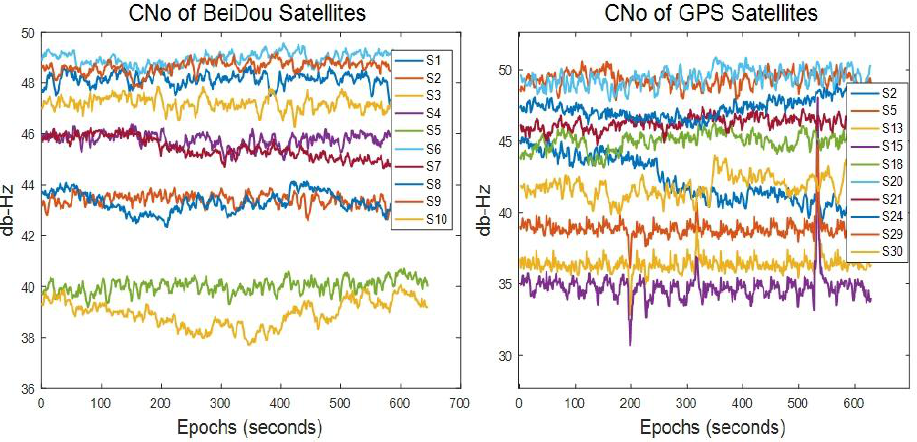
Figure 2. CNo of BeiDou and GPS-visible satellites for open sky data.